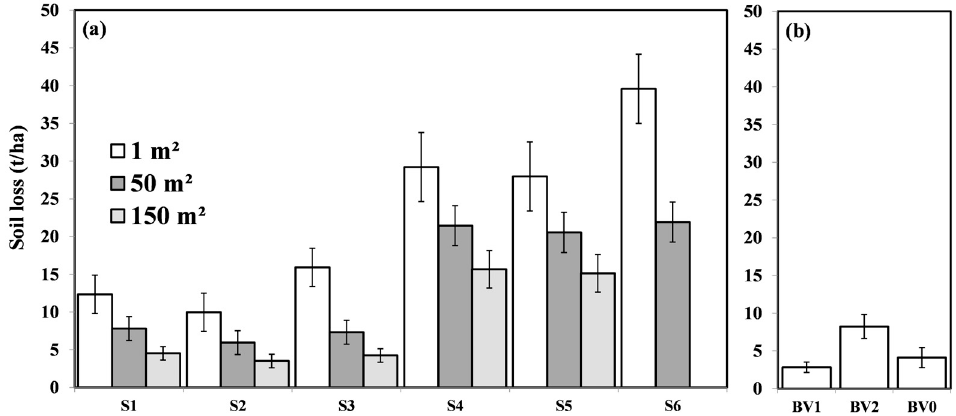
Figure 4. Average soil loss rates monitored in Tougou watershed over the period 2010–2018. ( a ) Soil loss rates measured on plots: sites S1 through S3, located on cultivated areas; sites S4 through S6, located on bare and degraded areas. ( b ) Soil loss rates for sub-watersheds (BV1 and BV2) and the Tougou watershed (BV0). The error bars on all histograms are defined based on nine values.